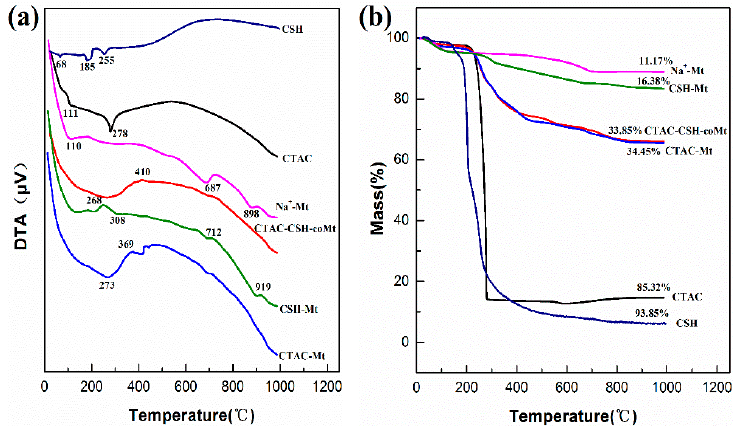
Figure 8. Differential thermal analyses (DTA) ( a ) and thermogravimetric (TG) ( b ) curves of CTAC, CSH, Na + -Mt, and OMt.